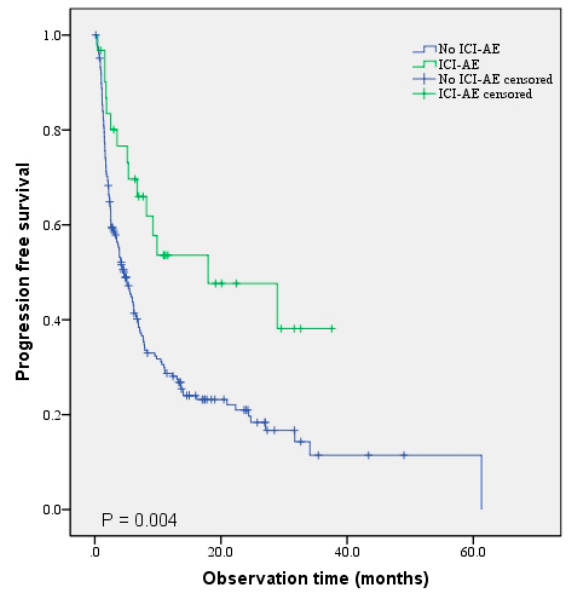
Figure 1. Comparison of PFS between the ICI-AE and without-ICI-AE groups. In the univariate analysis for OS, the number of metastatic lesions alone was signifi- cant. The multivariate analysis including sex, age, and factors that were significant in the univariate analysis also showed that only the number of metastatic lesions was significant ( p = 0.023) (Table 3). Table 3. Cox regression for PFS and OS in patients who received prior radiotherapy.